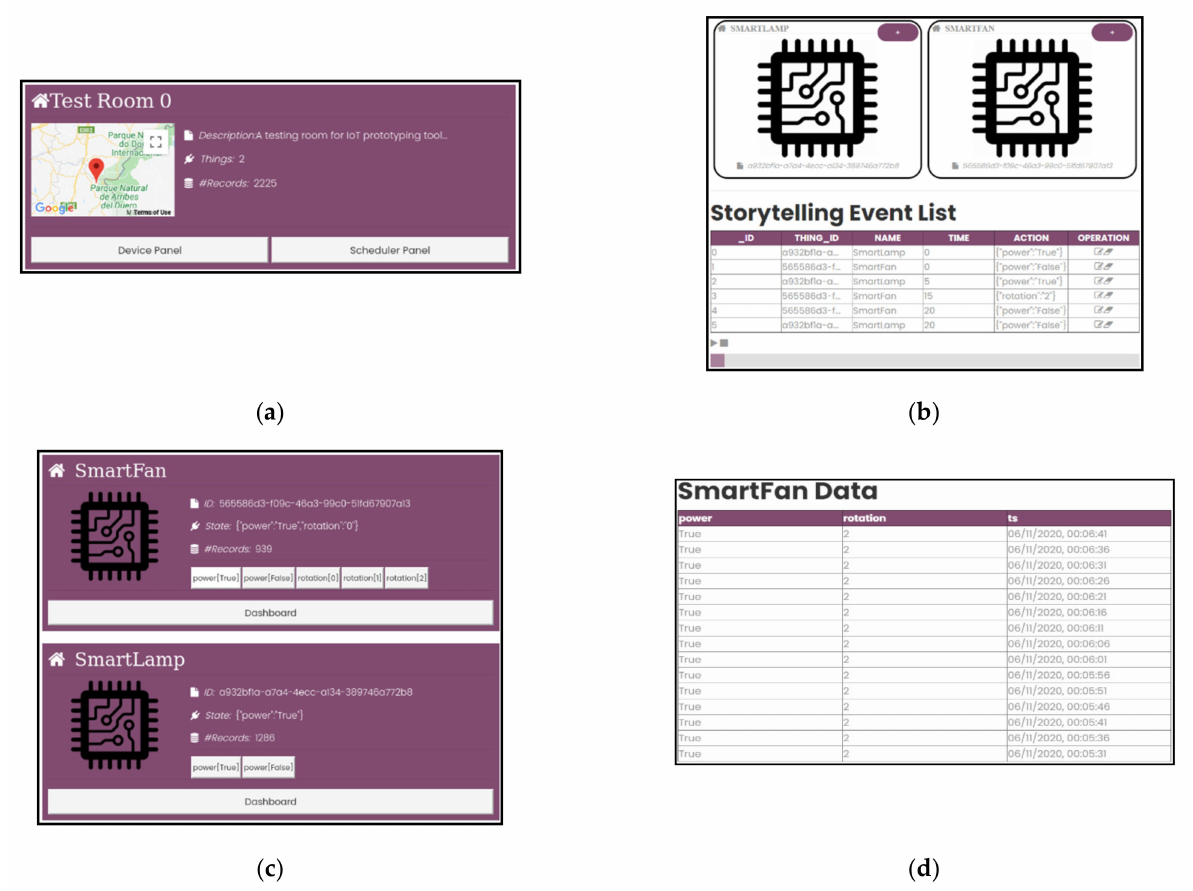
Figure 5. Web-based application manager: ( a ) general access panel to a room of test, corresponding to a virtual setup; ( b ) event scheduler to configure actuators features activation in a chronological manner; ( c ) control panel interfacing endpoints’ features at the virtual setup side; ( d ) data table regarding the registries associated to the activity of an exemplifying device (smart